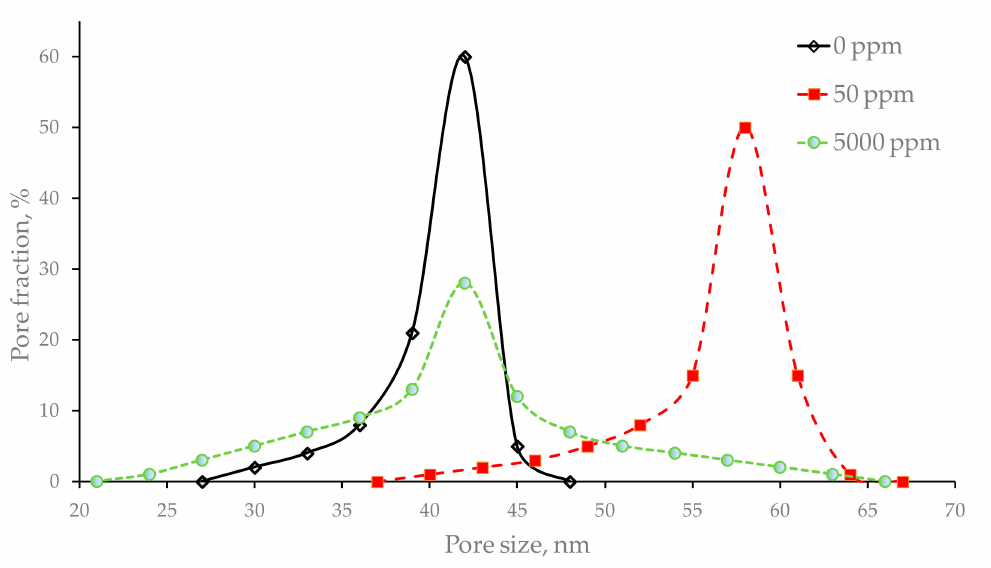
Figure 2. The pore size distribution of the untreated membrane (0 ppm) and membranes treated with solutions with active chlorine concentrations of 50 and 5000 ppm.